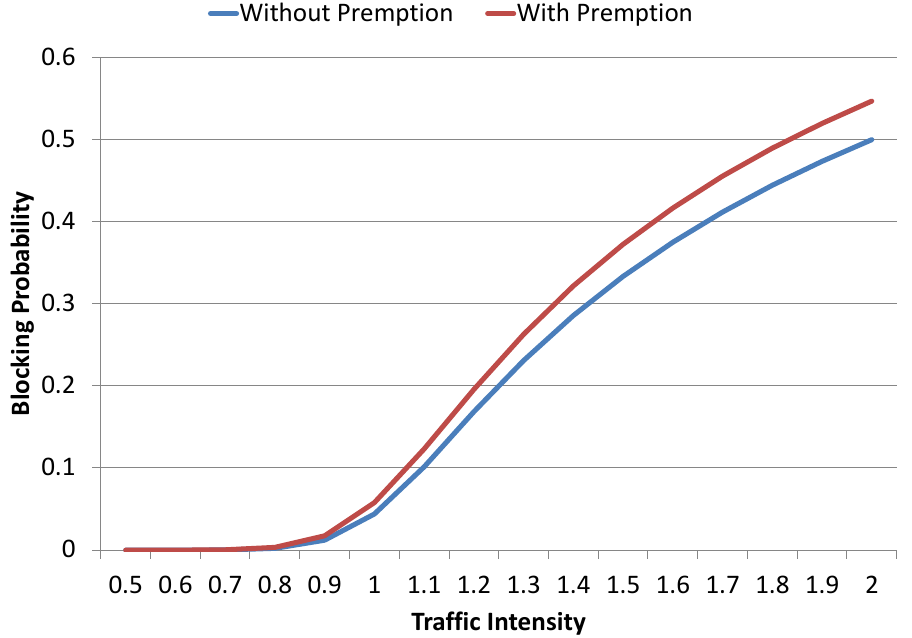
Figure 11. Comparative analysis of blocking probabilities for preemptive and non-preemptive model results with C = 30